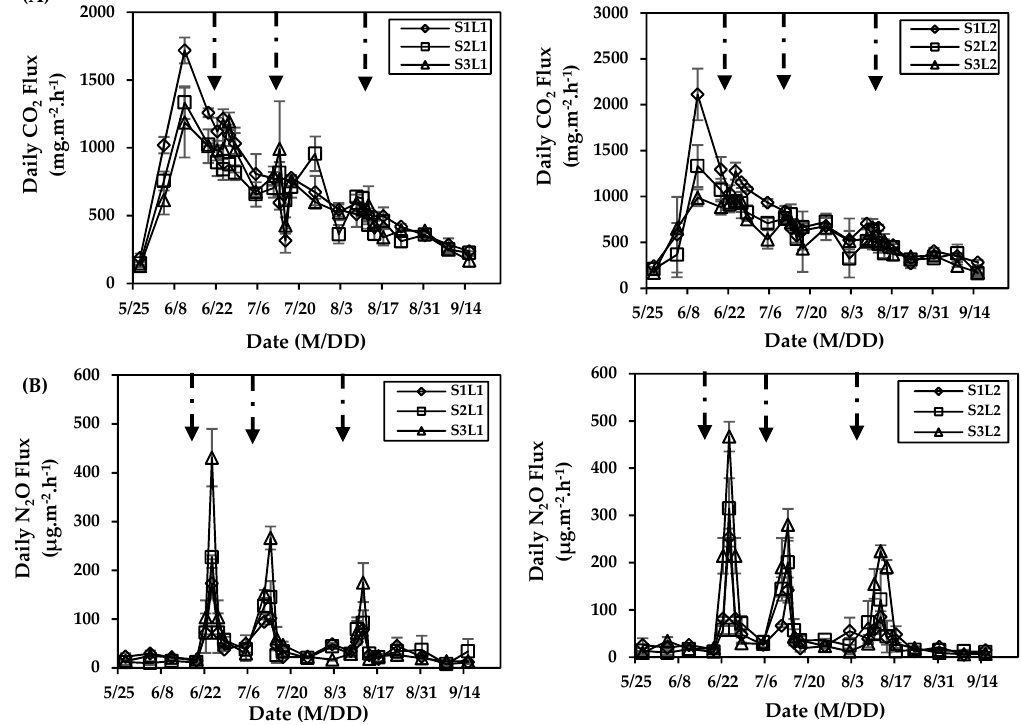
Figure 5. ( A ) Daily CO 2 flux and ( B ) daily N 2 O flux during the growth period of maize for different irrigation water salinity (S1, S2, and S3 for 2 g / L, 3.5 g / L, and 5 g / L, respectively) and alternate irrigation regimes (L1 and L2 for one saline water cycle and two saline water cycles, respectively). Symbols represent the mean of three repeated tests and error bars represent standard deviation. Solid arrows indicate fertigation events.